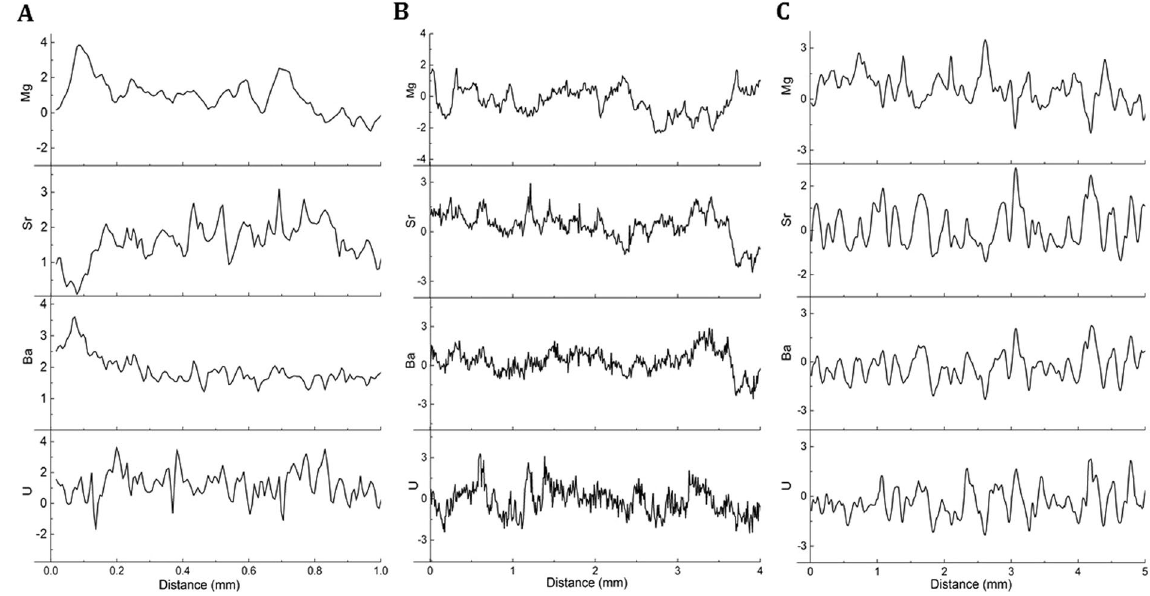
Figure 2. Typical sub-section of common trace element data (standardised) in each stalagmite ( A ) YD-S2, ( B ) LAB-S1 and ( C ) MND-S1. Note the x-axis varies for each stalagmite due to the different growth rates for each stalagmite; average growth rates are 0.41 mm (MND-S1), 0.065 mm (YD-S2), 0.352 mm